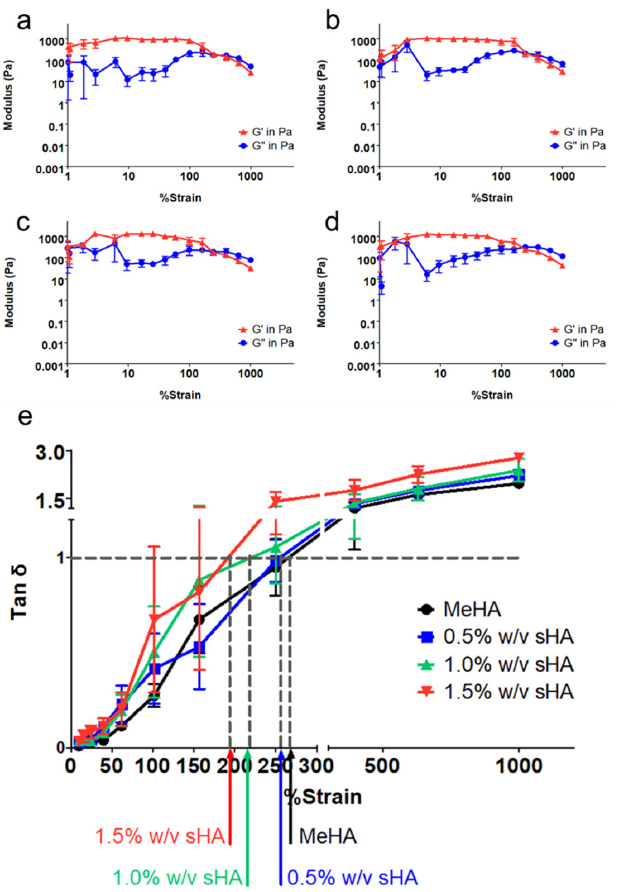
Figure 2. Mechanical profiles of hydrogels, ( a – d ) show the mechanical profiles of hydrogel formulations containing 0.0%, 0.5%, 1.0%, and 1.5% w / v of sHA, respectively. The relationship between tan δ and % strain is shown as in ( e ). Table 3. The mechanical analysis of four types of hydrogel formulations.